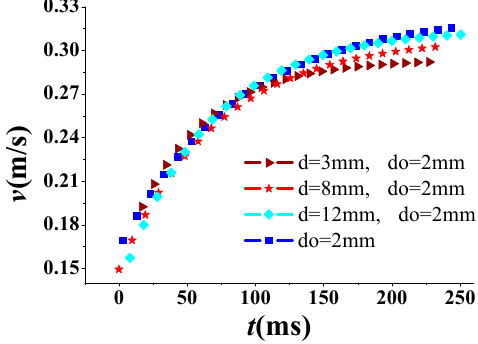
Figure 10. Velocity variation with time under different conditions.